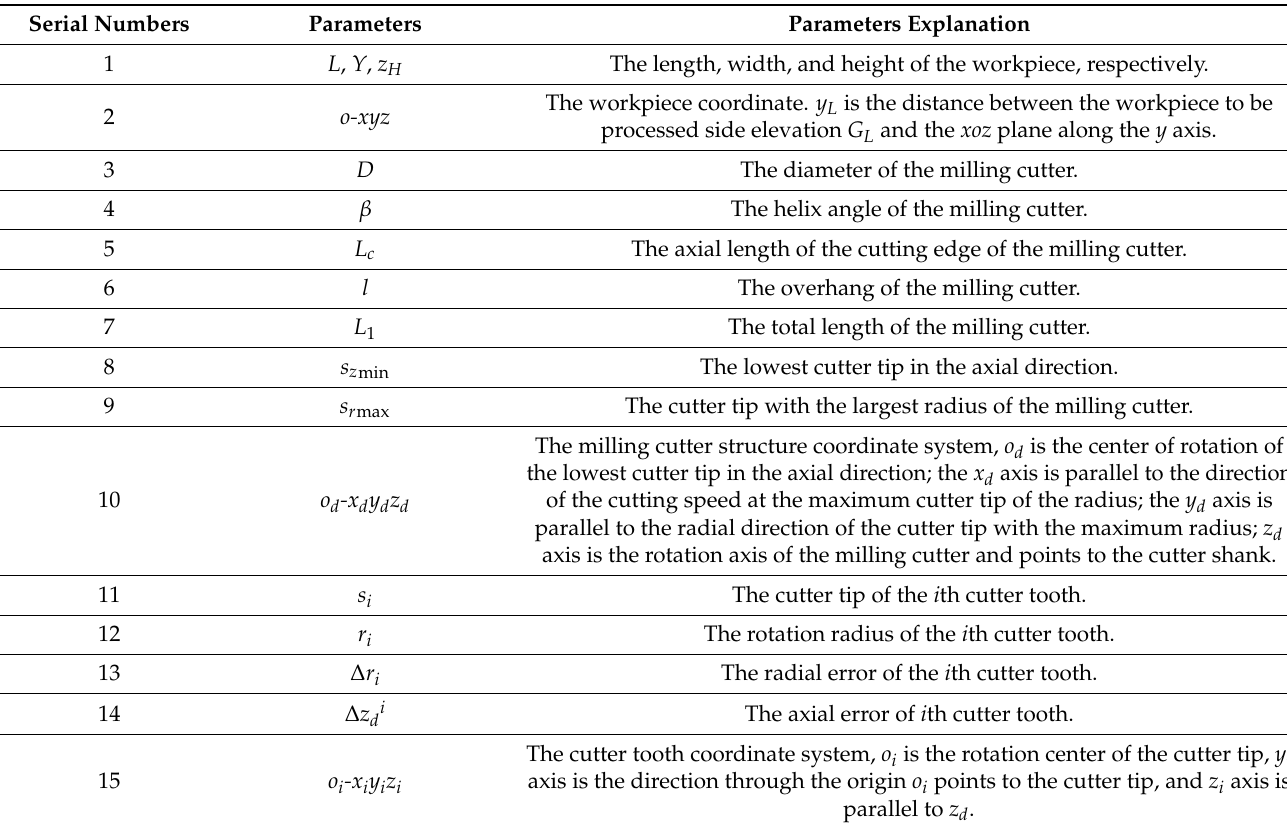
Figure 1. Instantaneous cutting behavior of the cutter under vibration. Table 1. Explanation of the cutting behavior of the cutter under